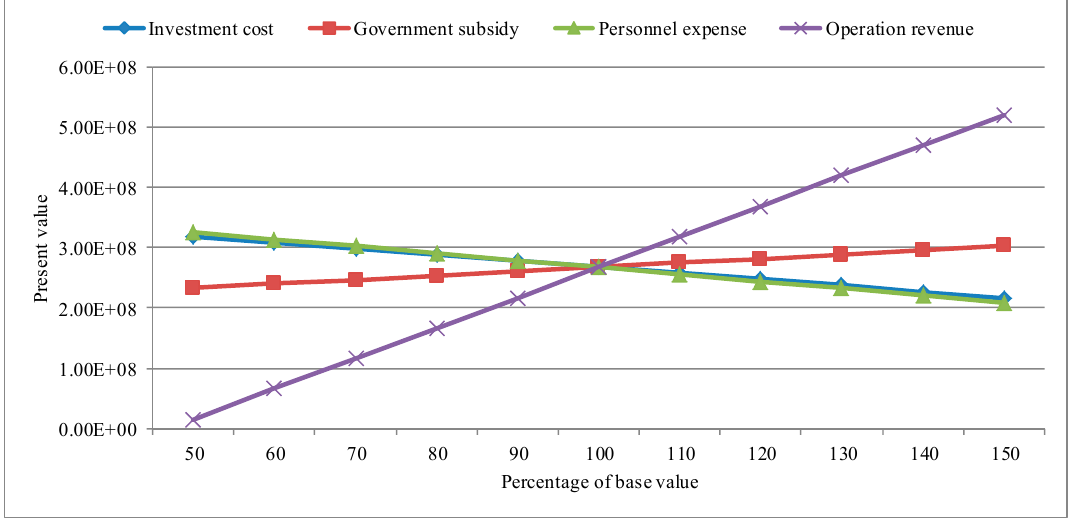
Figure 13. Sensitivity analyses of the uncontrolled charge.